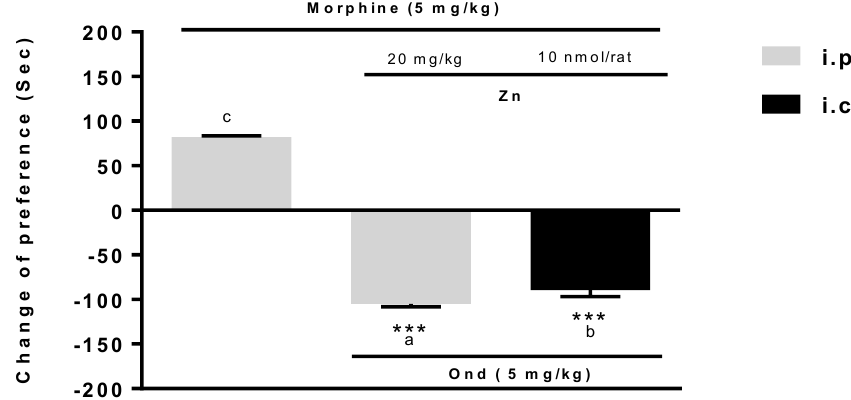
Figure 9. Effect of ondansetron on the enhancement effect of Zn on the expression of morphine-induced CPP. Zn was given i.p. (20 mg/kg) and i.c.v. (10 nmol/rat) separately after the ondansetron in the post-conditioning sections. Each point represents the mean± SEM of six rats. *** Presents significant between saline (10 ml/kg, i.p.) group at P < 0.001. Different letters indicate significant differences between groups (p<0.05) (Tukey’s post-hoc test). Zn=Zinc, and